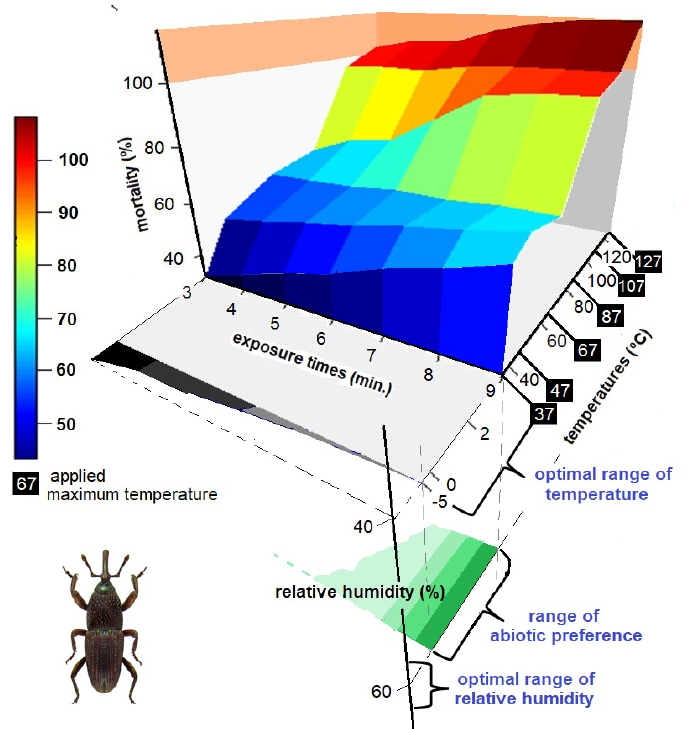
Figure 3. Extrapolation of the effect of maximum temperatures and their exposure time on mortality, based on the data from 5, 6, and 7 min exposure times, as well as the ecological preference [19] of the granary weevil (under 40% rh).